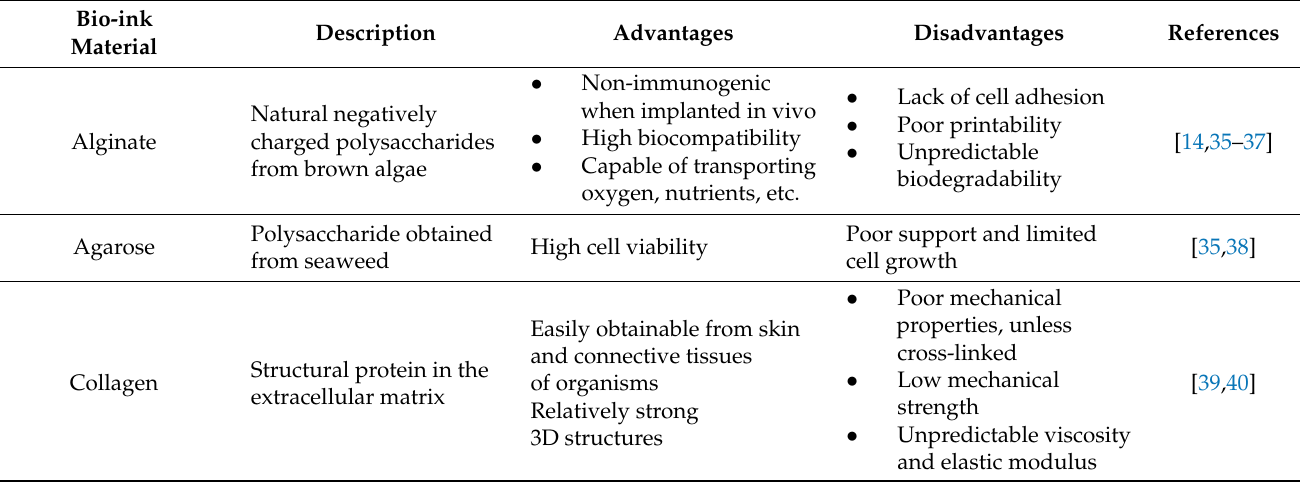
Table 2. Summary of available natural and synthetic